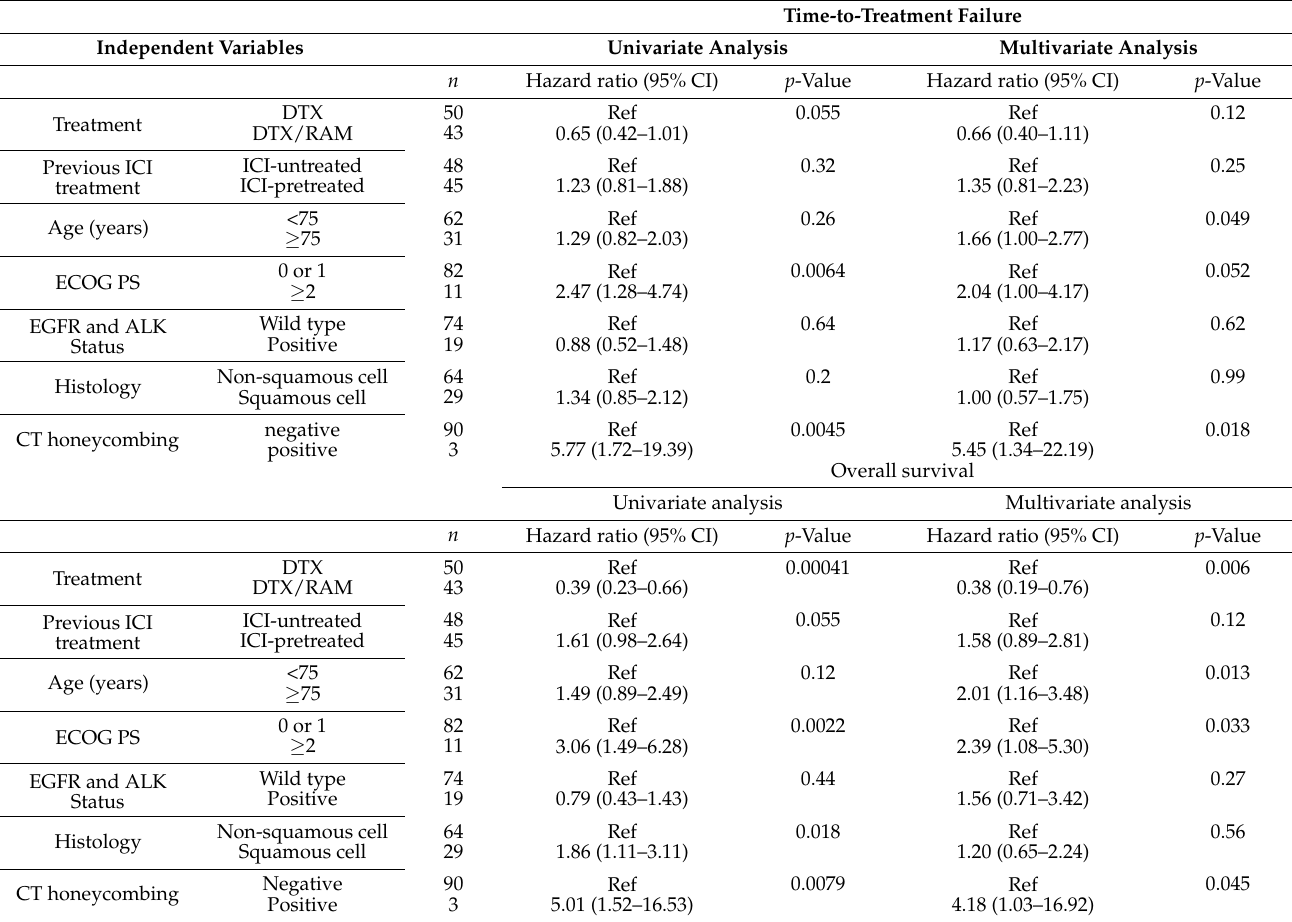
Table 3. Univariate and multivariate